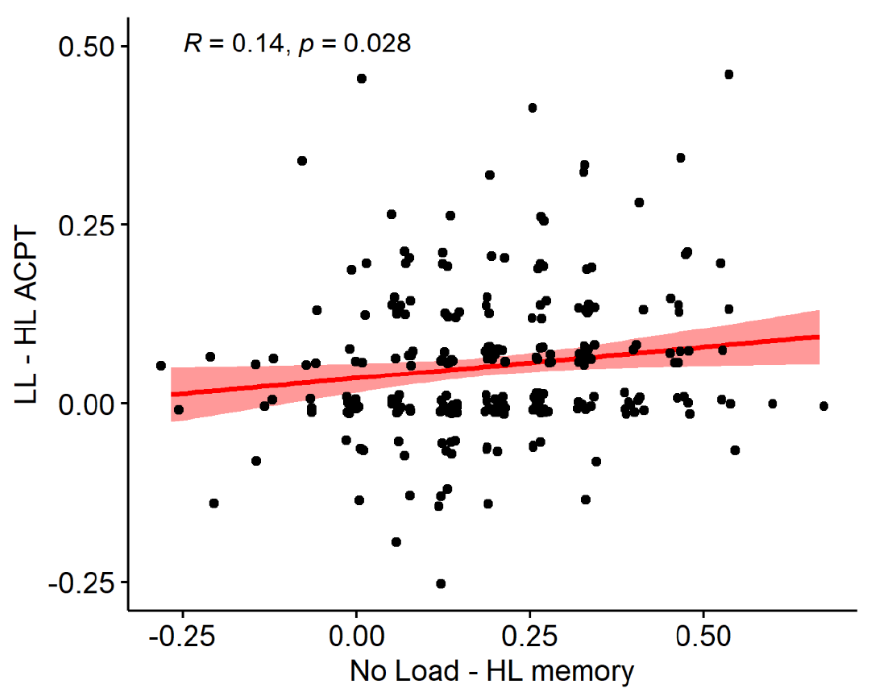
Figure 6. Correlation between the mnestic dual-task interference DTi (No Load–HL) and ACPT DTi (LL–HL). The bands represent 95% confidence intervals. Positive values indicate that more errors were committed in the High Load condition than in the Low Load (ACPT) or No Load (memory task) conditions. Table 7. Descriptive table for Age, auto-GEMS score, and Education score by cluster. The three different columns encompass participants with different levels of sensitivity to dual-task interference (DTi). The low-DTi cluster (left column) includes participants whose performance suffers less from dual-tasking. By contrast, the high-DTi cluster (right column) includes participants whose performance suffers more from